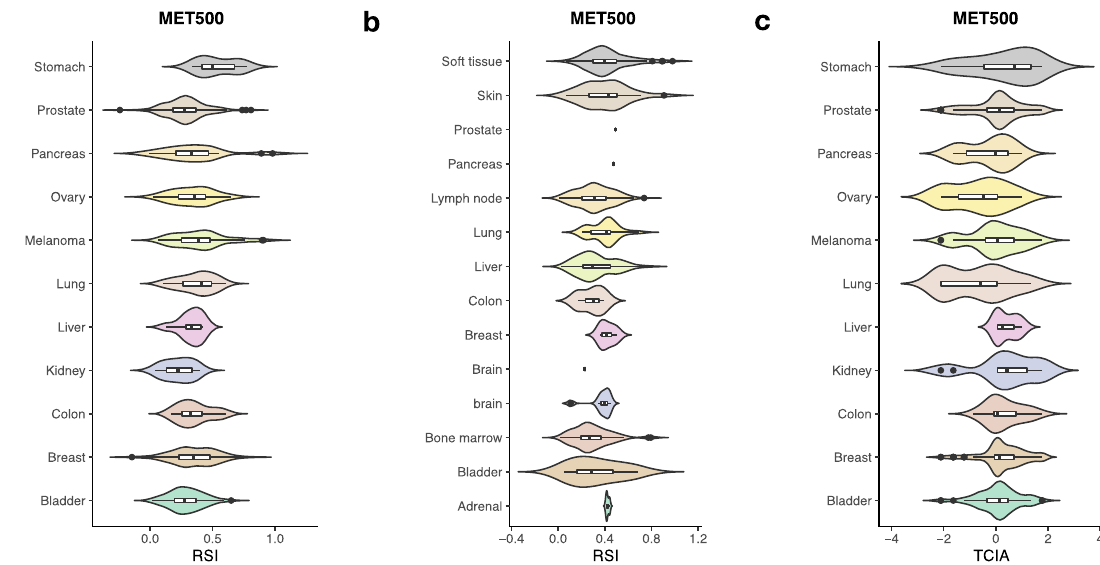
Fig. 5 RSI in the metastatic tissues. a RSI in metastatic tissues in the MET500 cohort. b RSI of tumours in various metastatic tissues. c TCIA scores in the 11 cancer types. The black horizontal lines represent the